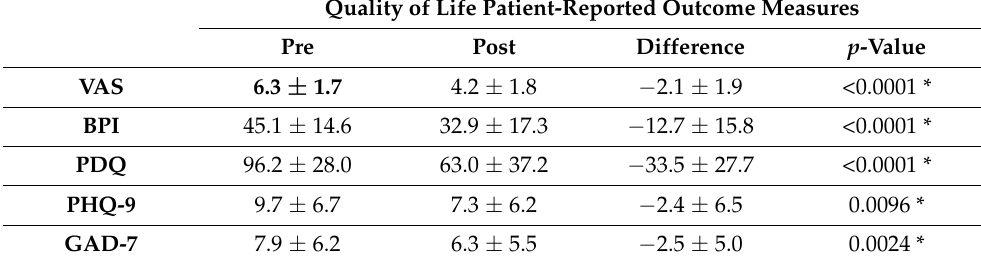
Table 3. Mean QoL-related assessment responses.